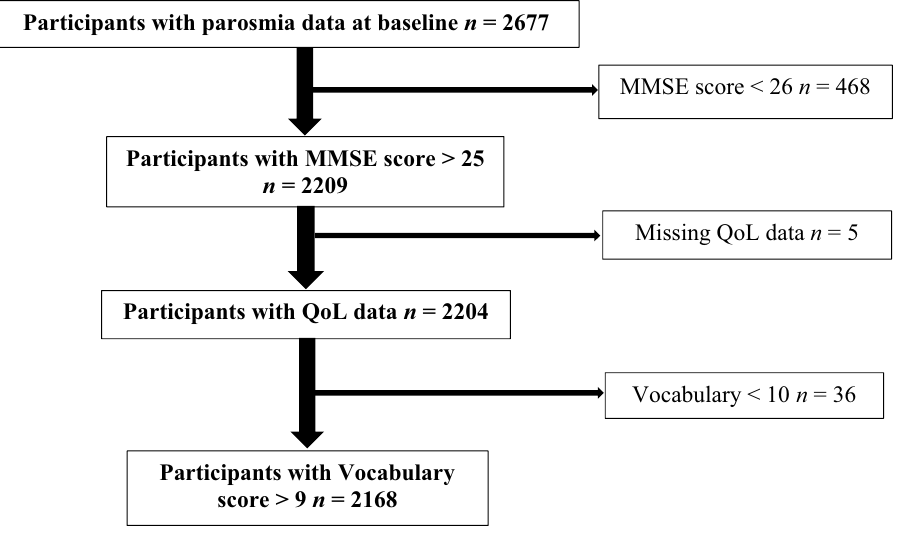
Figure 1. Exclusion flowchart. MMSE, Mini-Mental State Examination. QoL, Quality of Life. Vocabulary, Vocabulary